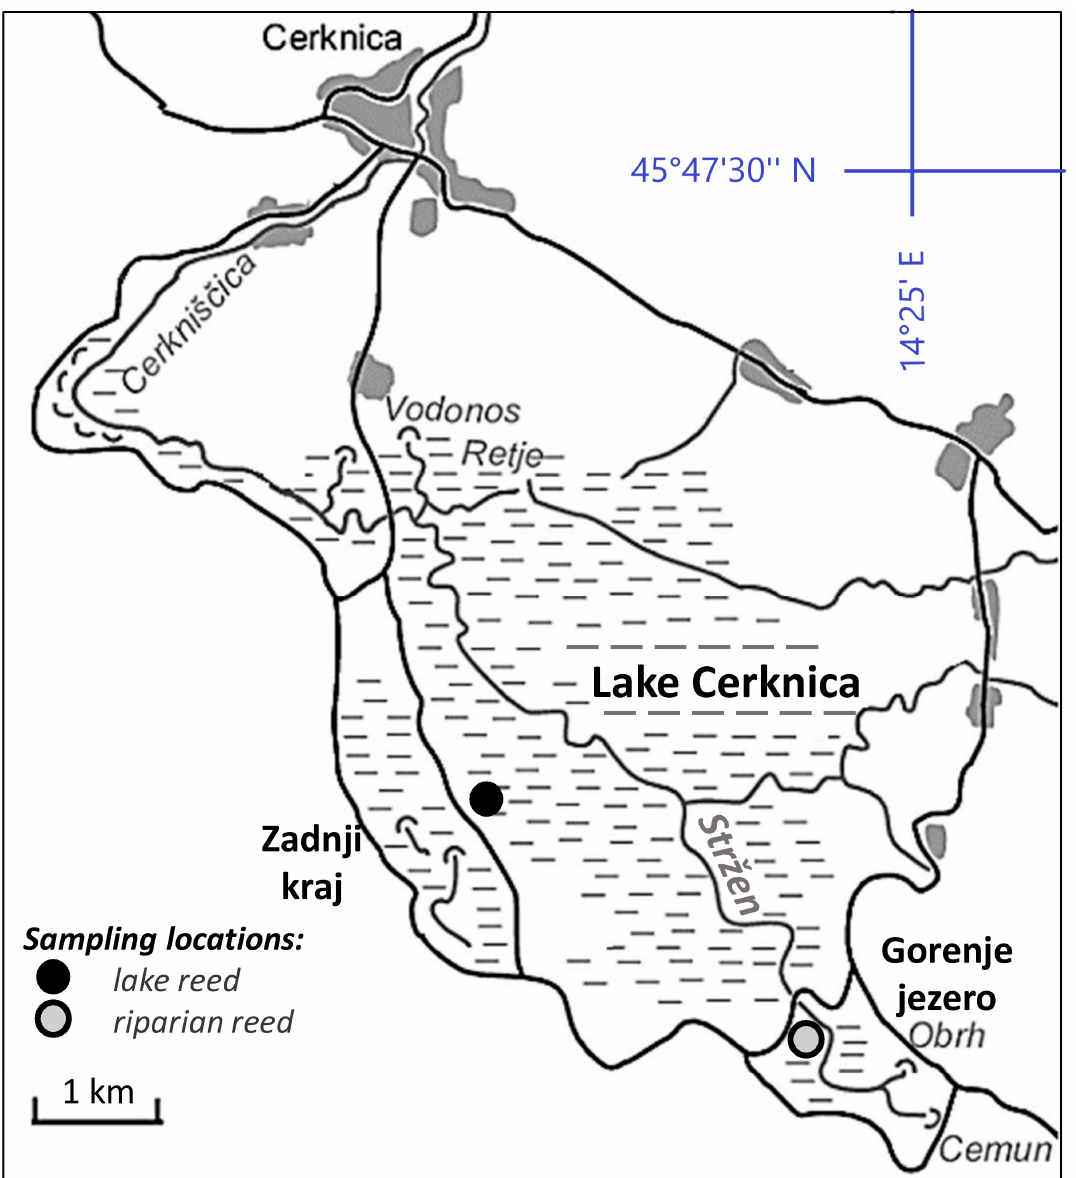
Figure 1. Map of the study area showing the two sampling locations.